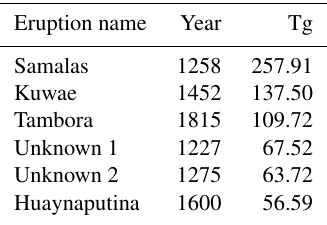
Table 2. The six largest tropical eruptions of the last millennium and their total global stratospheric sulfate injection (Tg) as recorded by Gao et al. (2008), revised in